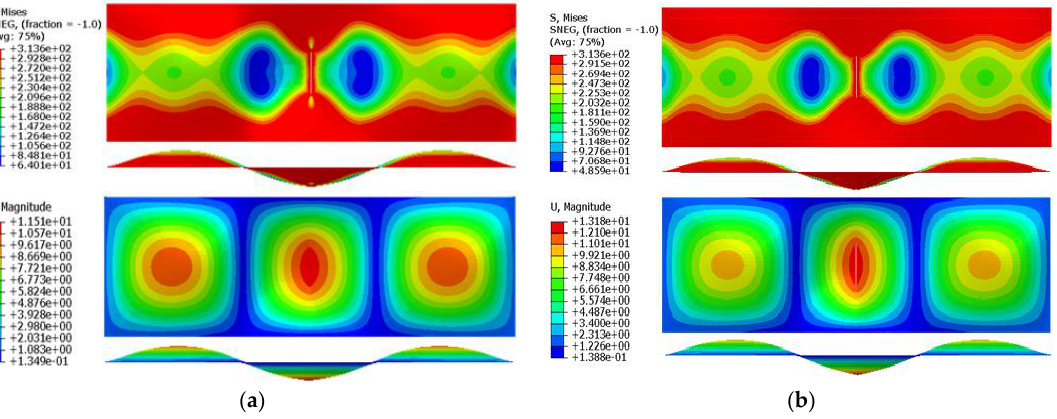
Figure 15. Load-displacement curves of plate with prefabricated crack and fatigue crack at 2𝑐/𝑏 = 0.3: ( a ) Compressive residual strength; ( b ) Tensile residual strength. In addition, the stress distribution and out-of-plane deformation of the prefabricated crack model when it reaches the limit state are also similar to the crack formed by crack propagation, as shown in Figures 16 and 17. Therefore, from the above analysis, it can be seen that crack propagation has little impact on the residual strength assessment of cracked plates.